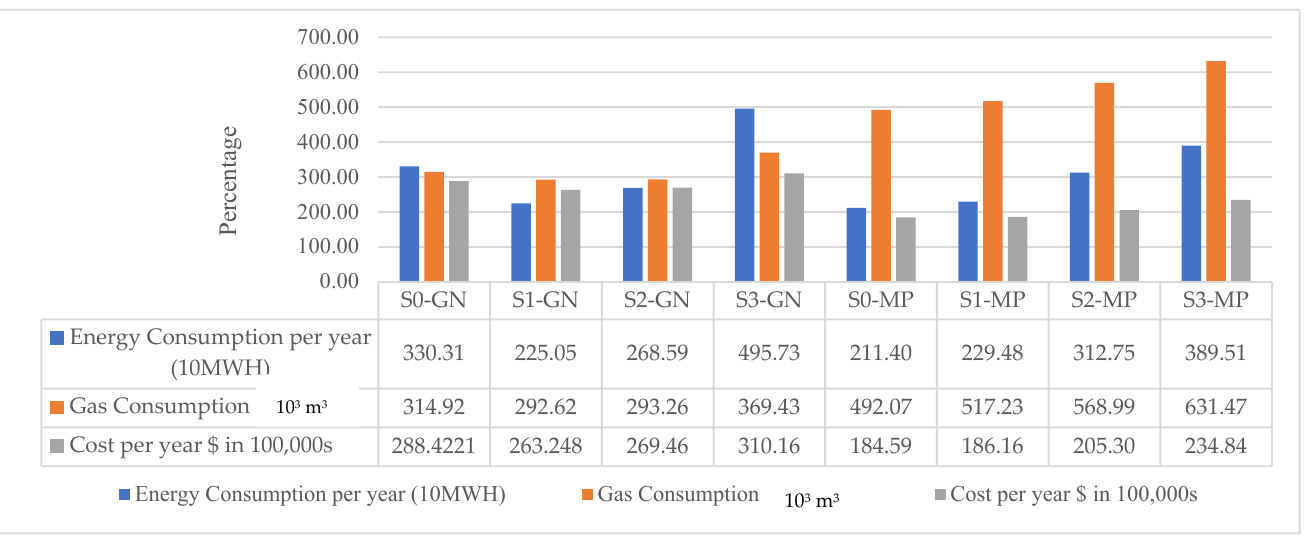
Figure 5. Comparison between real and simulated scenarios of GN and MP. Table 2. Simulation scenarios for both case studies. (a) Available Scenarios for Murabba Palace,